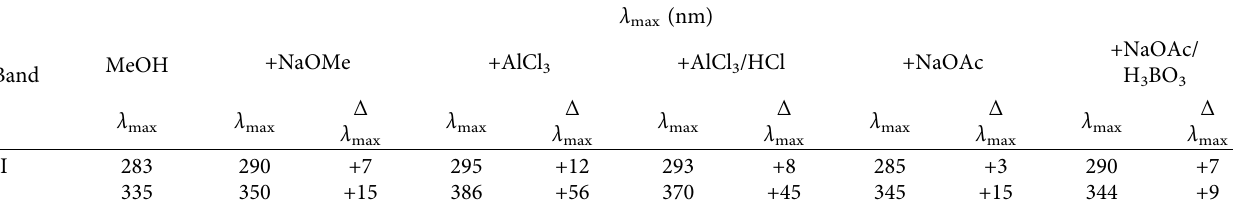
Table 2: UV spectral data of compound (10) in methanol and with diferent ionizing and complexing reagents.